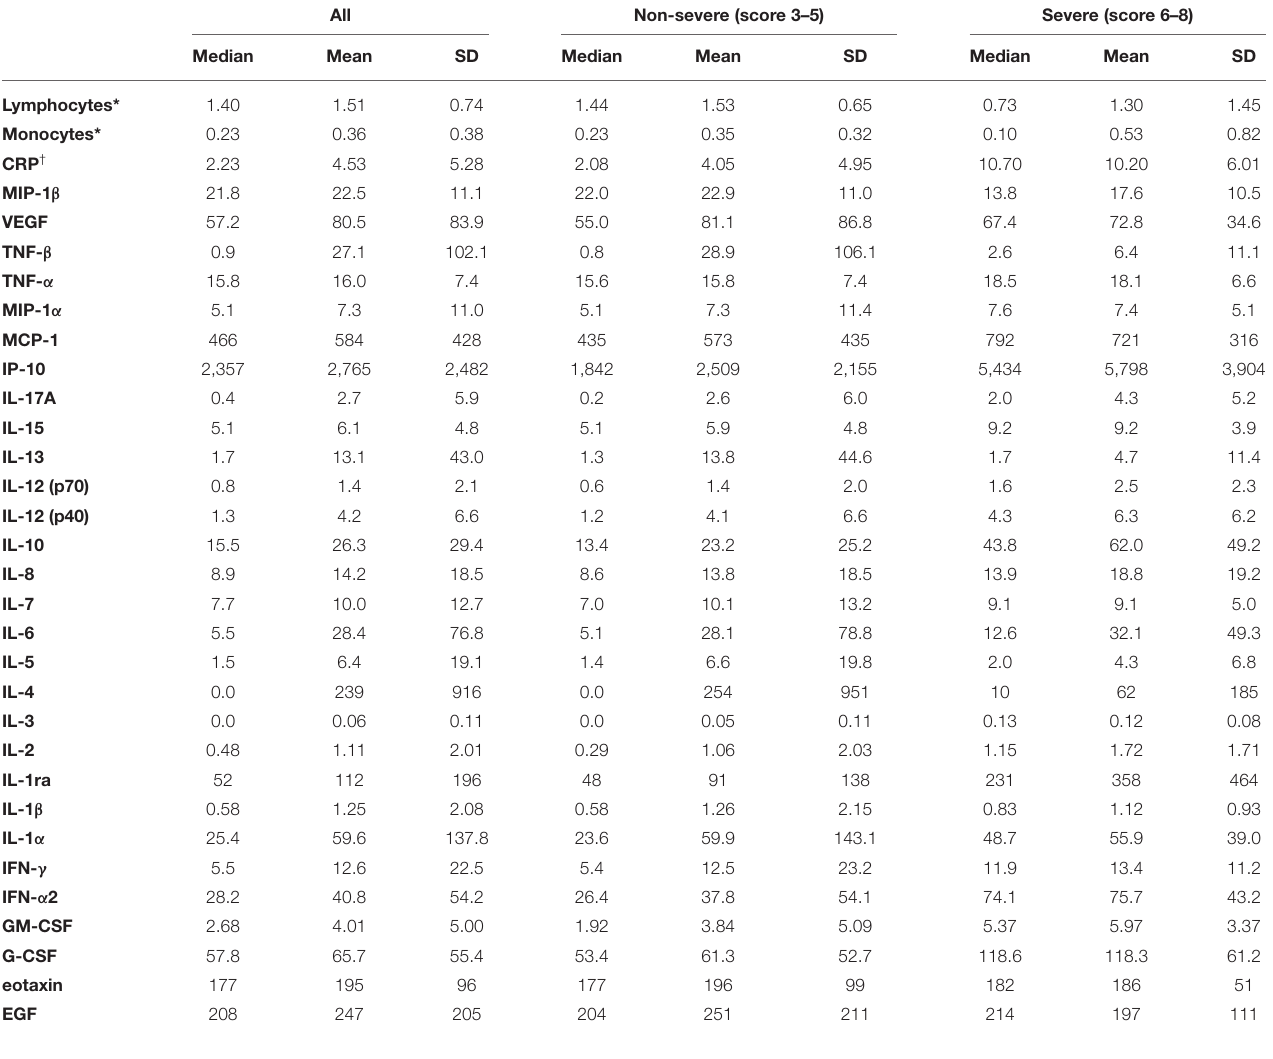
TABLE 2 | Biomarker levels according to WHO Ordinal Scale for Clinical Improvement.